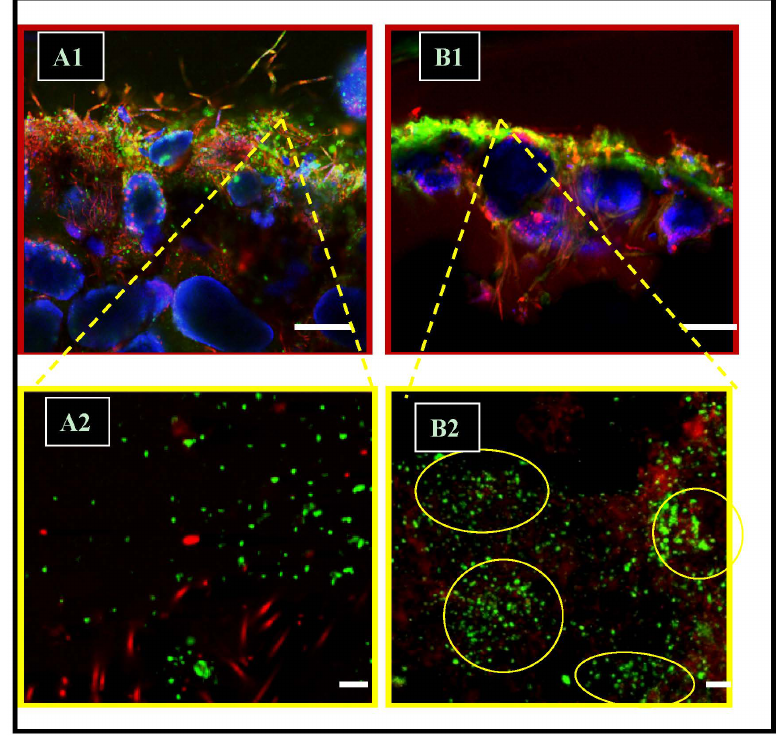
Figure 2. Confocal scanning laser micrographs (CSLM) illustrating relative changes microspatial distributions of SRM cells near the surface of ( A1 , A2 ) Type-1 ( i.e. , relatively-scattered) and ( B1 , B2 ) Type-2 ( i.e. , highly-clustered) mats. Images are cross-sections of surface mats showing SRM cells (green fluorescence; dsrA FISH probe), heterotrophic bacteria (red fluorescence stained with propidium-iodide (PI)) and cyanobacteria (red autofluorescence), and ooid sediment grains (artificial blue-color). Yellow circles illustrate typical clustering of SRM cells. Scale bars in A1 and B1 = 100 µm; in A2 and B2 = 10